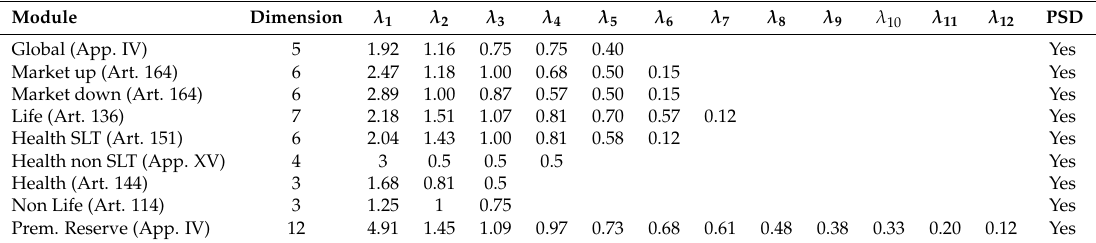
Table 1. Eigenvalues of correlation matrices in Solvency II regulation (the matrices are available in EIOPA (2015), with further details concerning the corresponding article or appendix in the table).